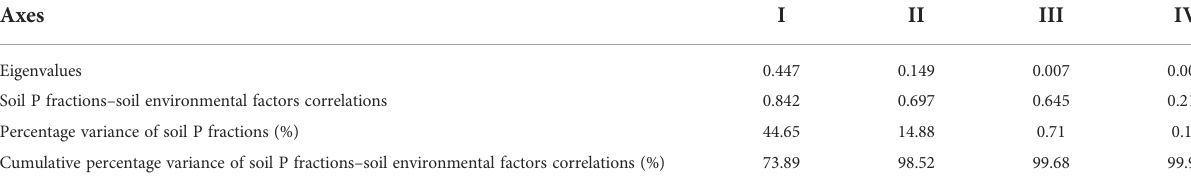
TABLE 4 Soil P fractions in relation to soil environmental factors in experiment